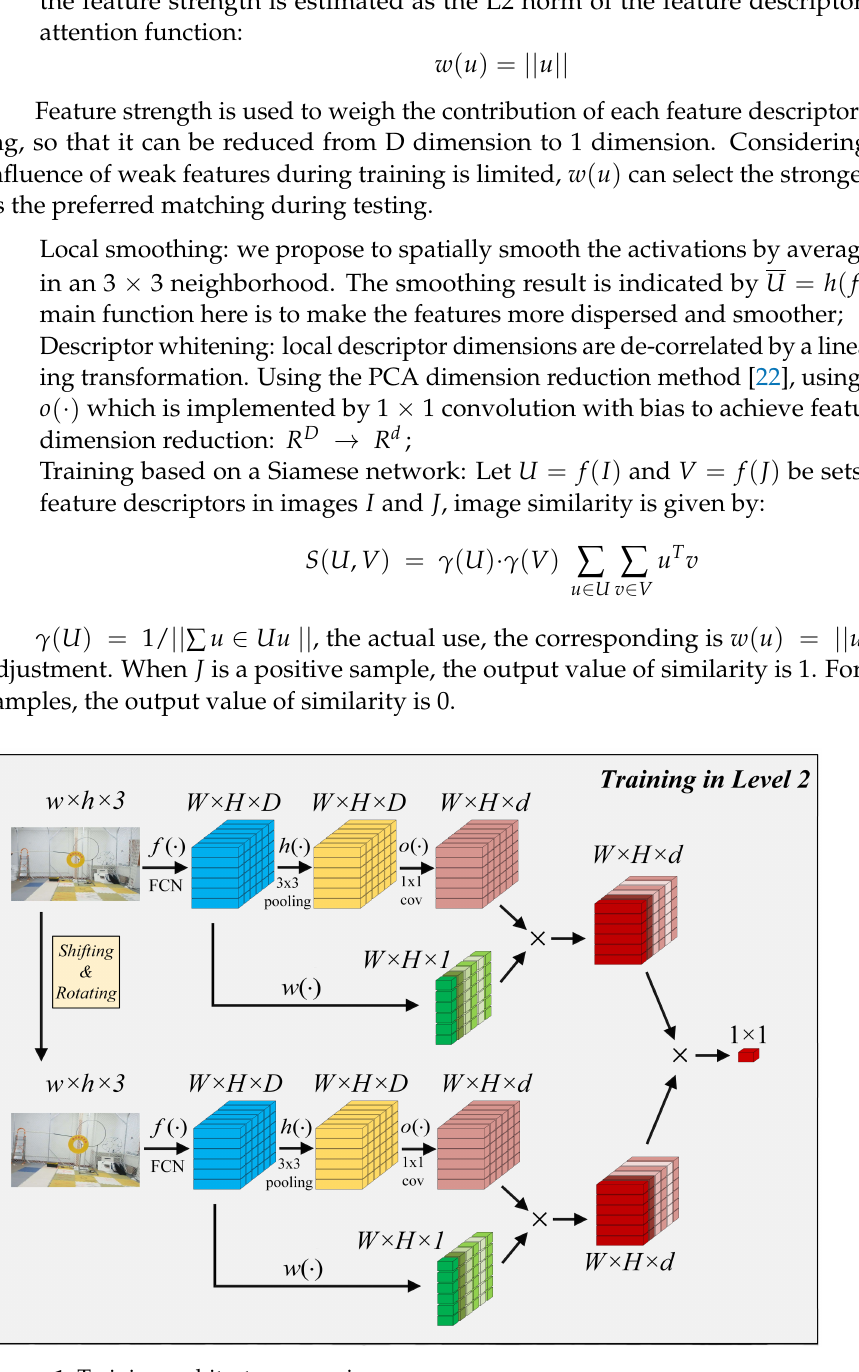
Figure 1. Training architecture